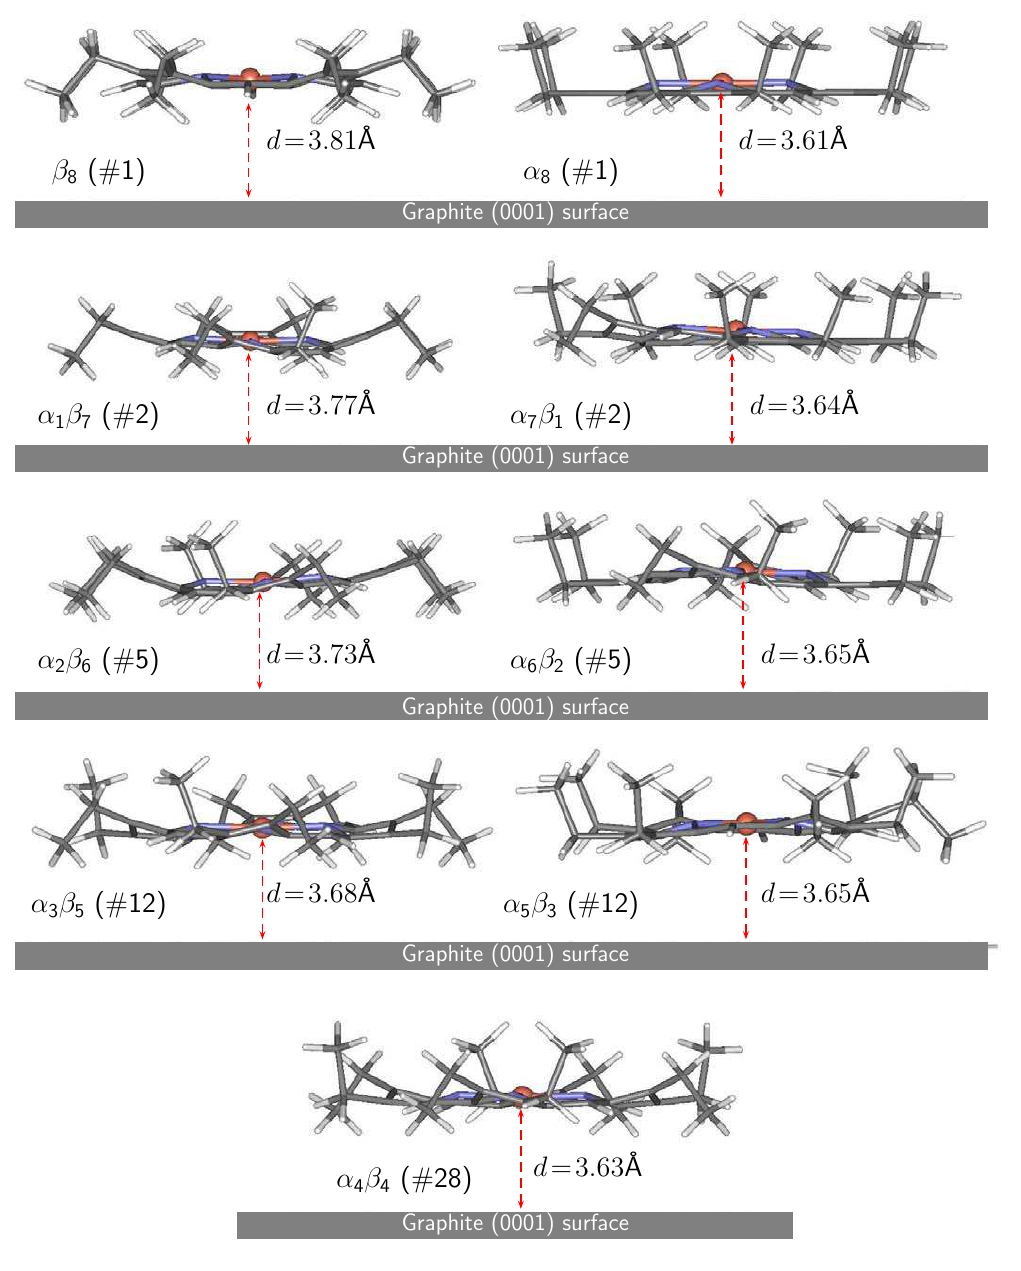
Figure 4 . Selected equilibrium conformations of Ni(OEP)—graphite structure. Characteristic structures from the least stable ( β